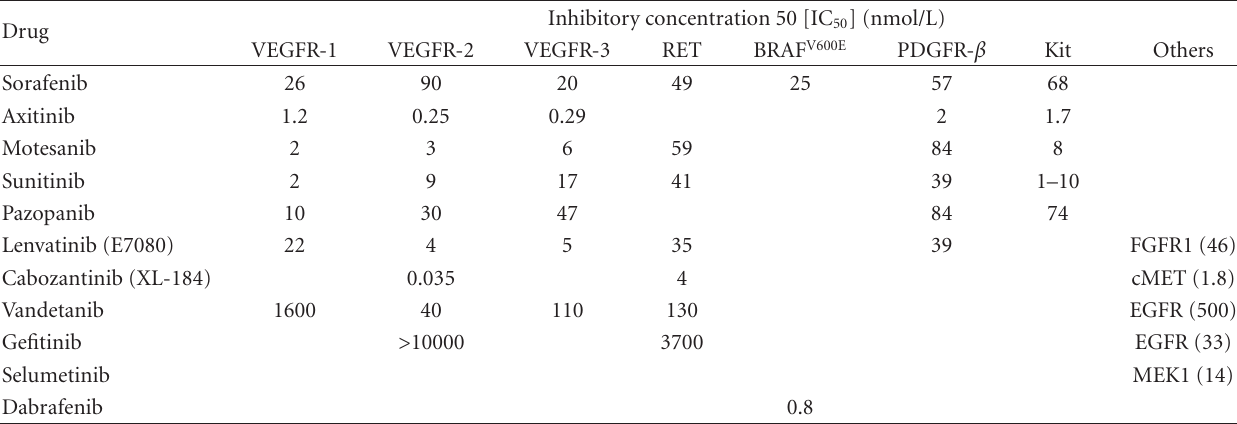
Table 1: Kinase inhibitor activities of target therapies on thyroid cancer